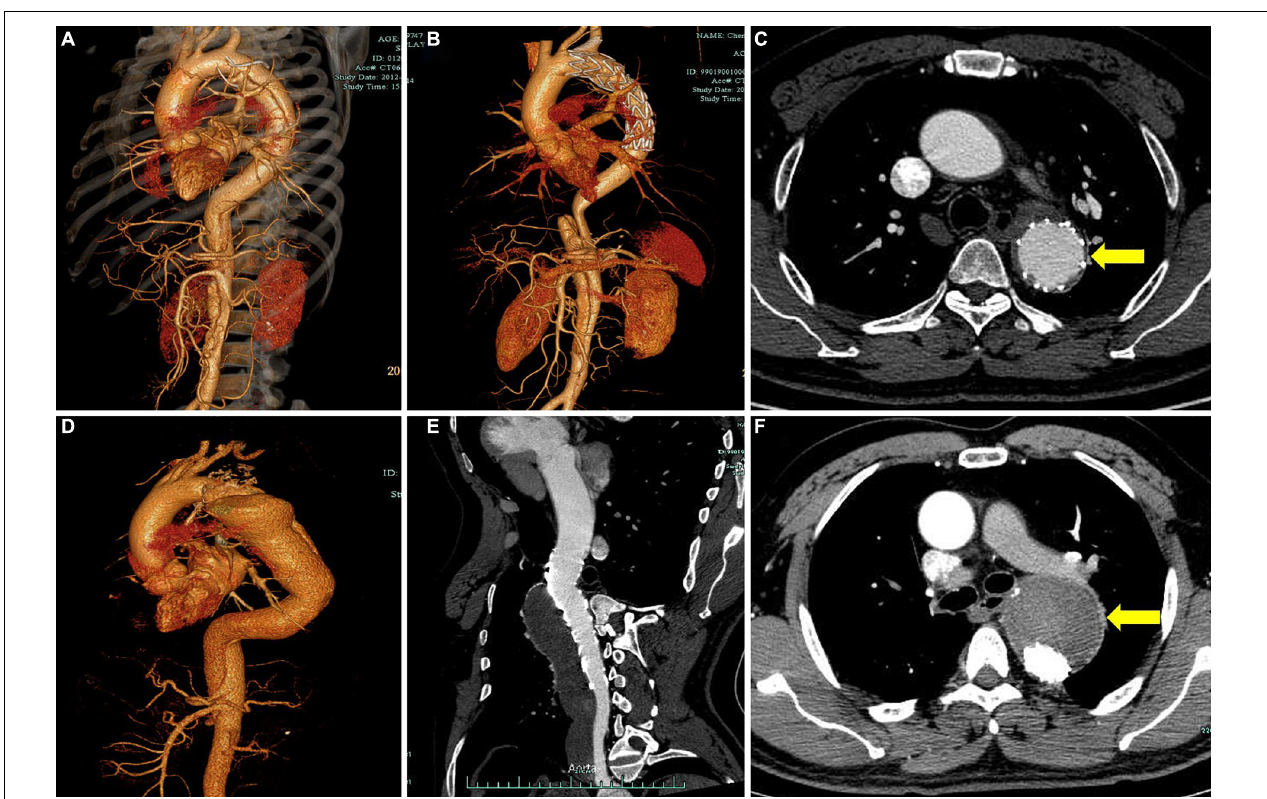
FIGURE 2 | Representative cases of different degrees of FL thrombosis after TEVAR. Computed tomography angiography (CTA) images show the FL status of a patient with subacute aortic dissection before operation (A) and 2 years after TEVAR (B) . The cross-sectional image shows complete obliteration of FL ( C , yellow arrow). CTA images show the FL status of a patient with chronic aortic dissection before operation (D) and 2 years after TEVAR (E) . The cross-sectional image shows total FL thrombosis ( F , yellow arrow). FL, false lumen; TEVAR, thoracic endovascular aortic